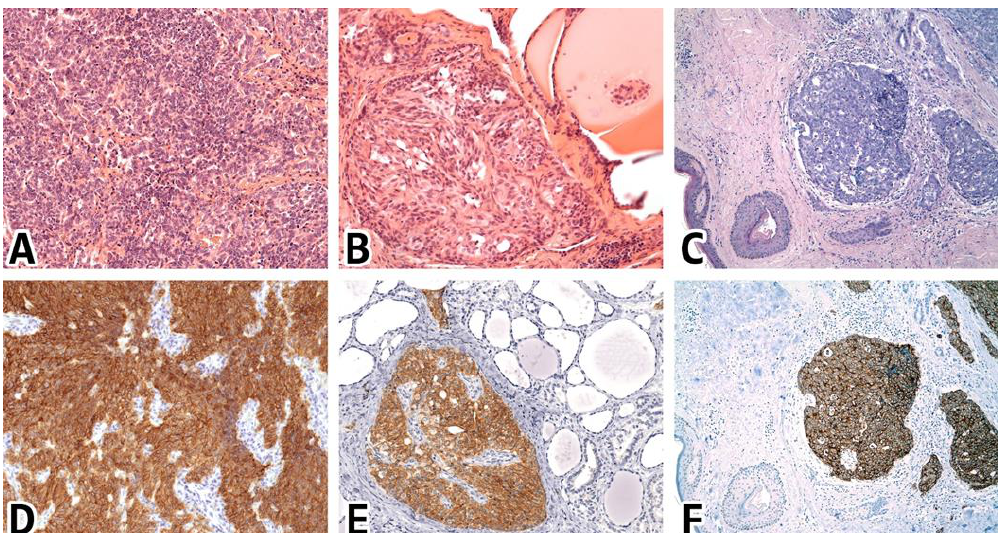
Figure 5. STX1 immunoreactivity in various types of NECs. ( A – C ) Hematoxylin-eosin stainings; ( D – F ) STX1 immunohistochemistry (IHC) reactions; ( A,D ) small cell NEC of the lung, 20x; ( B,E )